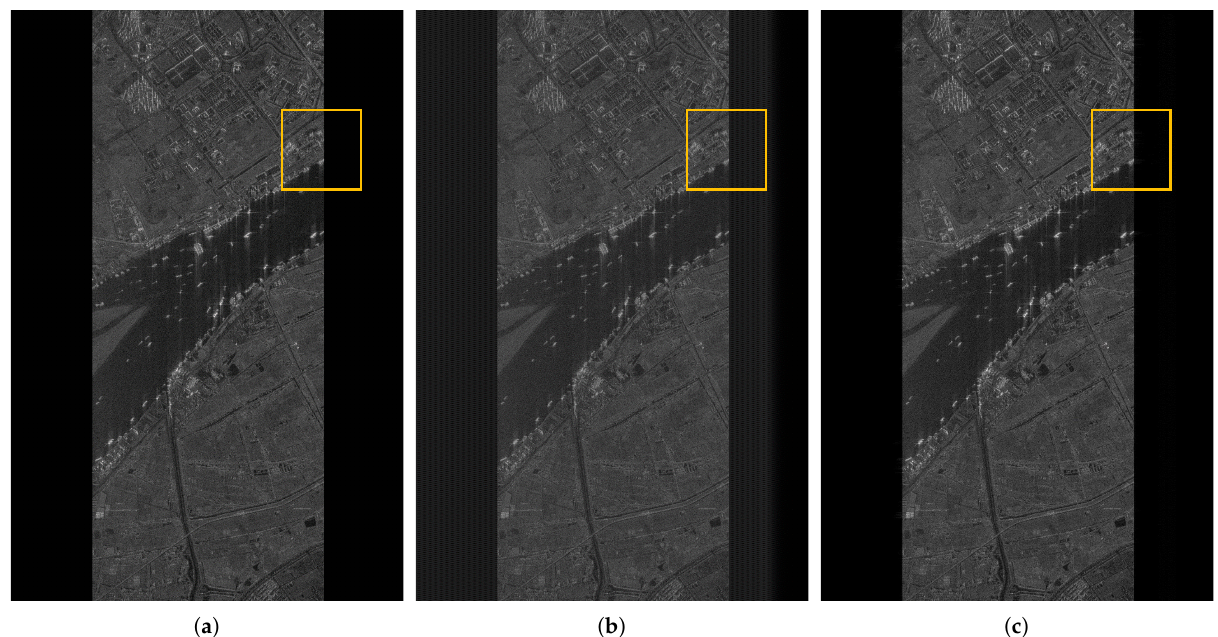
Figure 17. The imaging result. ( a ) The reference image. ( b ) Without removal of synchronization signal. ( c ) After removal of synchronization signal.